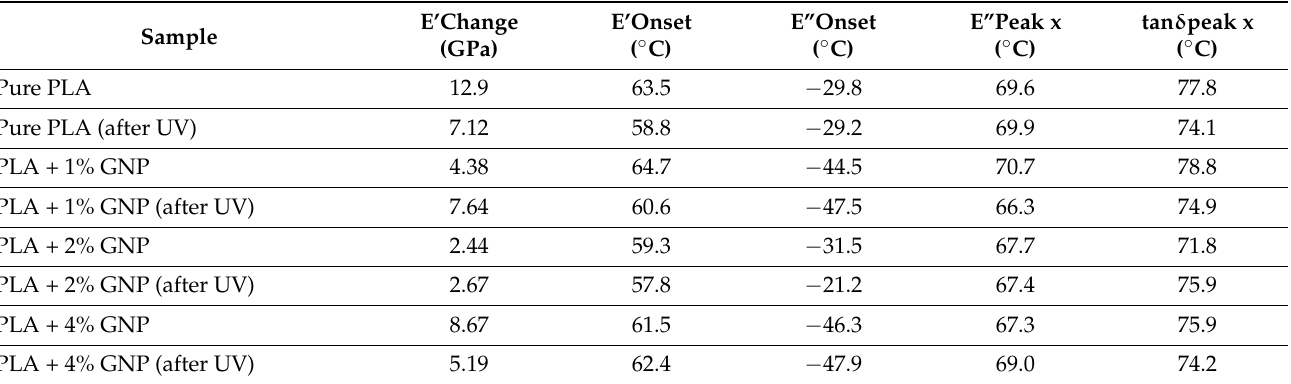
Table 3. Characteristic parameters read from charts based on